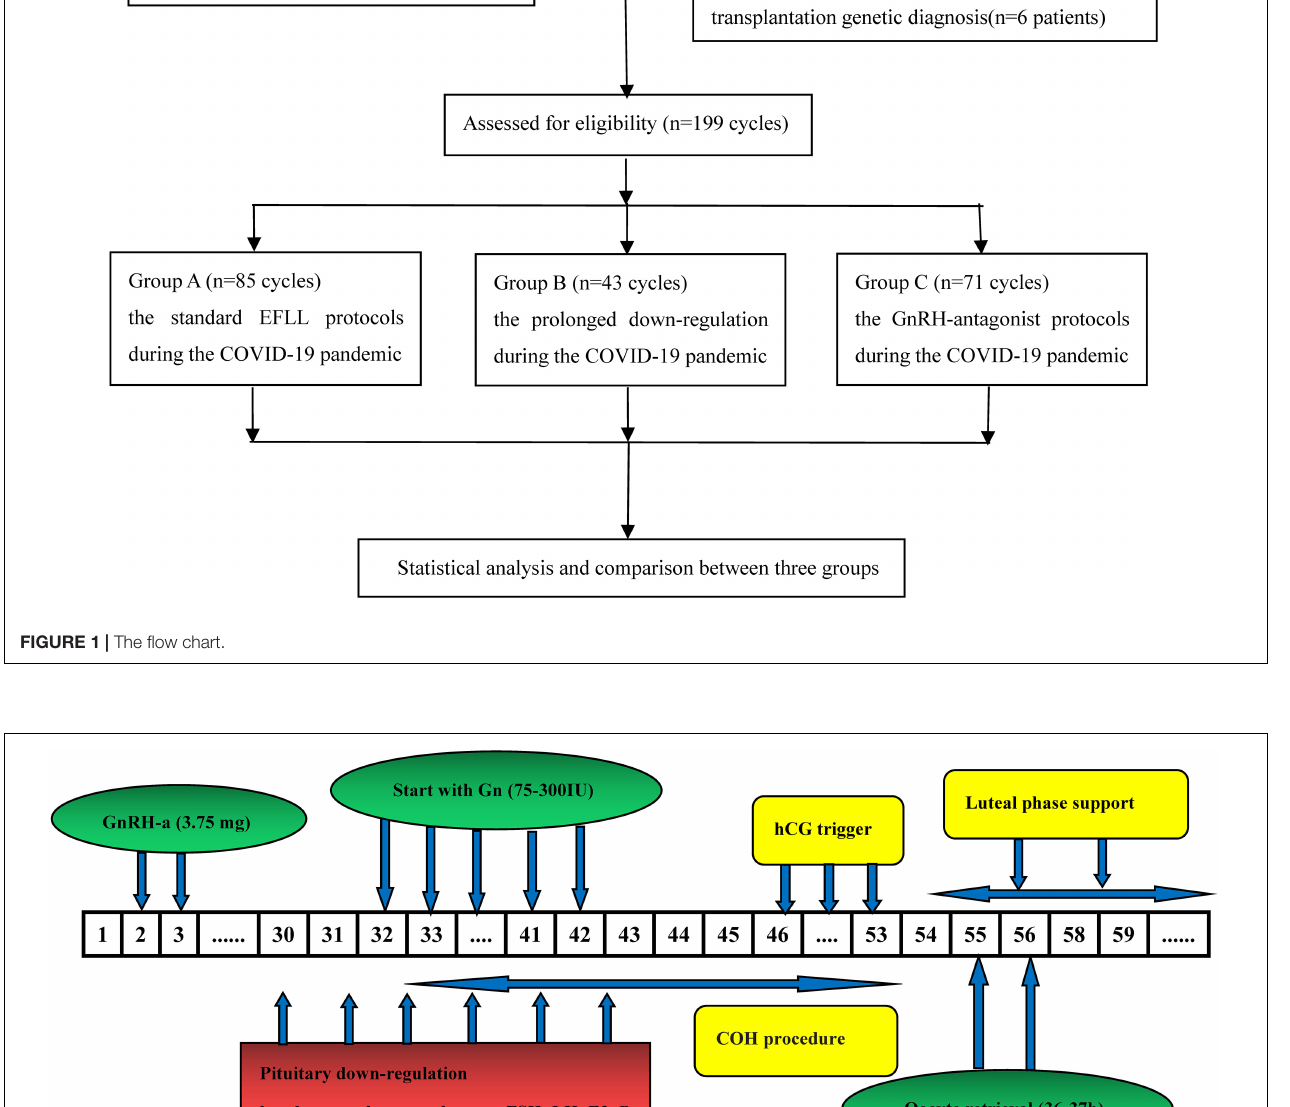
Frontiers in Physiology |